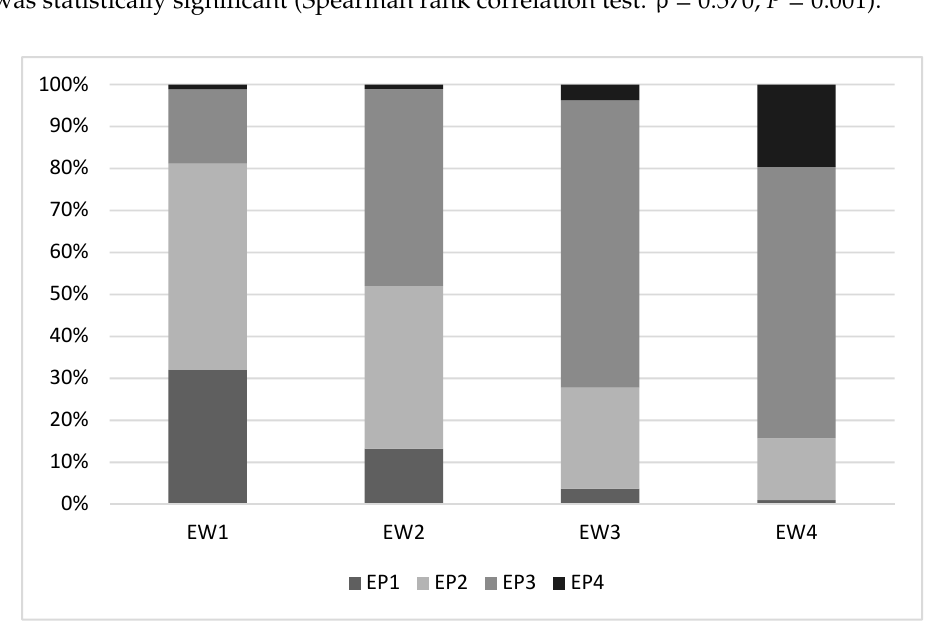
Figure 3. Association between eye white and ear posture: the highest percentage of eye white clearly visible corresponds to the highest percentage of ear in upright position, and to the lowest percentage of ear hung down loosely.